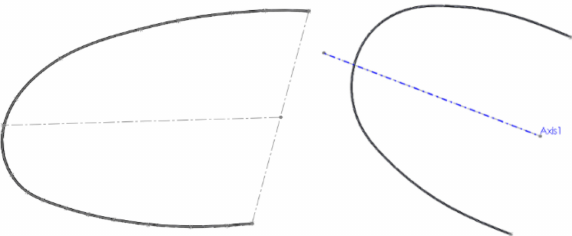
Figure 15. Virtual models of the two undeformed orthodontic wires.